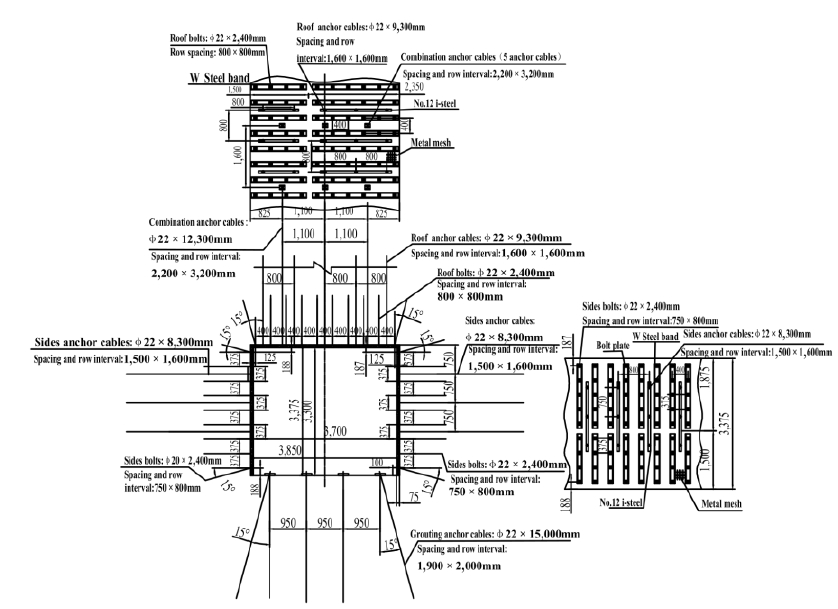
Figure 13. The roadway support layout plan. (2) Grouting